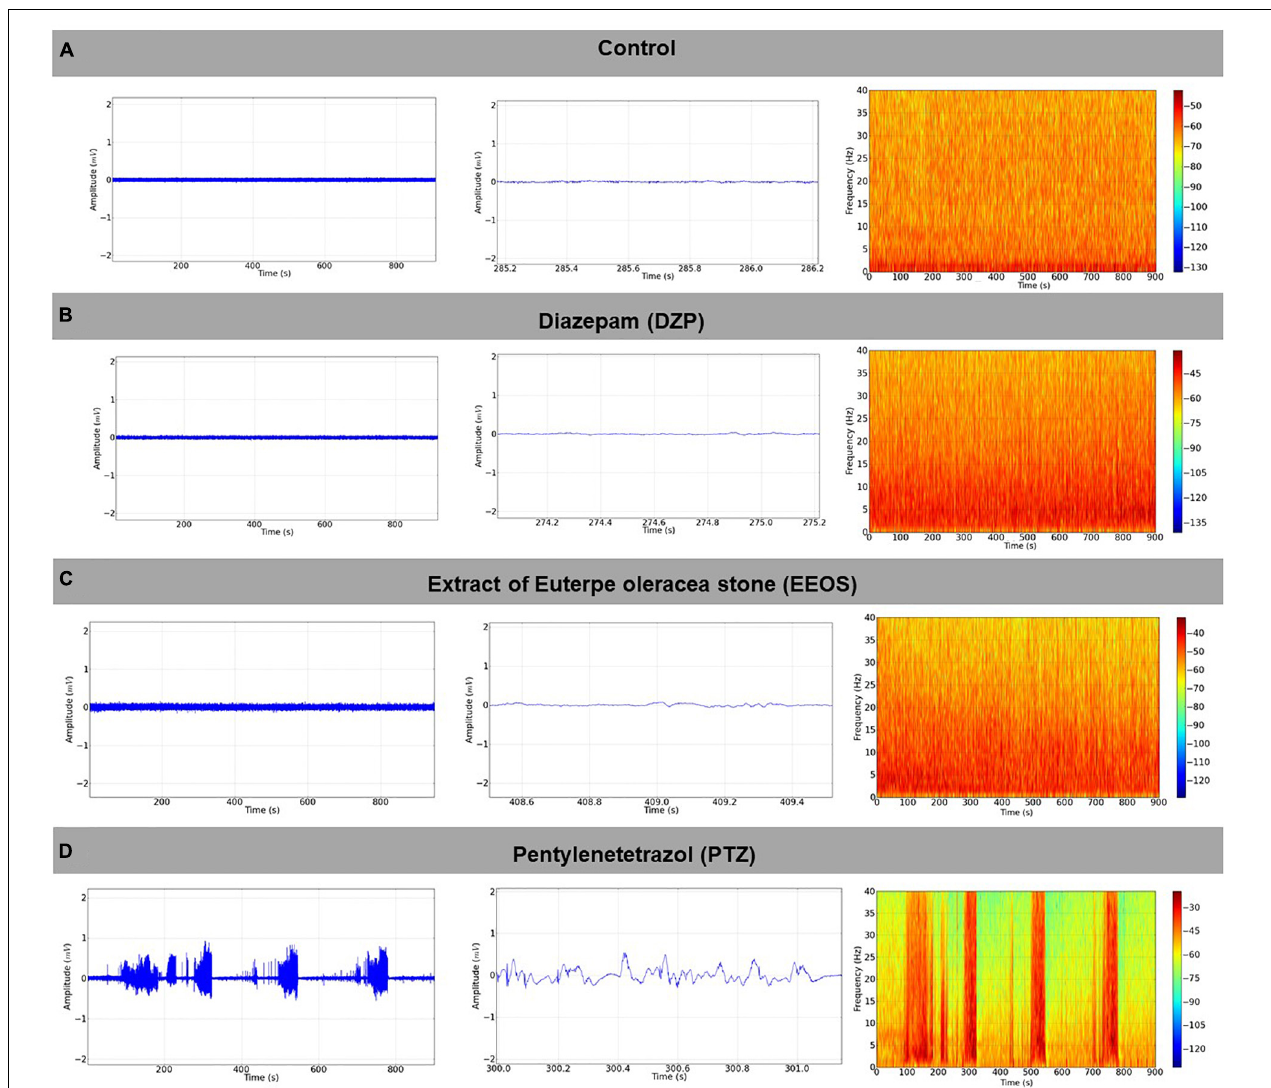
FIGURE 1 | Baseline electroencephalogram (EEG) tracing, the signal obtained from the right hemisphere, using as a reference the left hemisphere with 1 s magnification (in the center), and the respective energy distribution spectrogram (right) (A) ; electrocorticographic (ECoG) tracing after diazepam (DZP) administration (5 mg/kg i.p.) (left), with 1-s amplification (center) and power distribution spectrogram (right) (B) ; ECoG record observed after the administration of extract of Euterpe oleracea stones (EEOS) (300 mg/kg i.p.), with magnification and spectrogram (C) , ECoG tracing after administration of pentylenetetrazol (PTZ) 60 mg/kg i.p., with amplification containing 1 s of the recording in the tracing, and a spectral energy distribution graph (spectrogram) (D) (900 s record length).